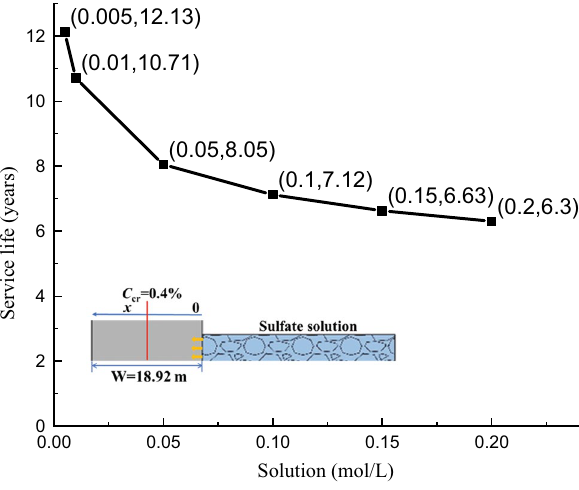
Fig. 9 Concentration development as a function of time at the dis- tance of half width of the coal dam